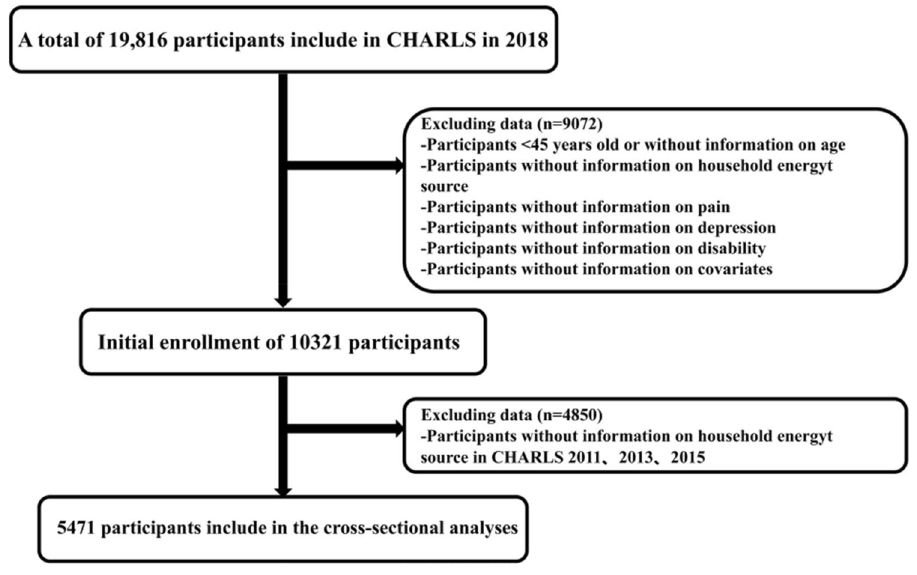
Figure 1. Inclusion process of participants (N =